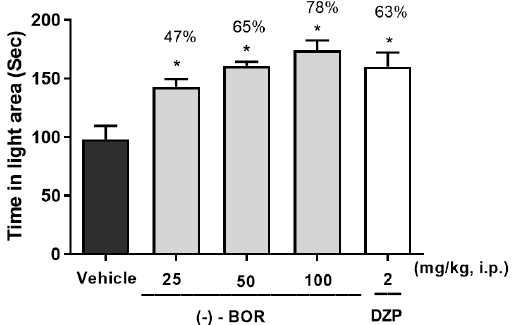
Figure 4. The effect of (–)-BOR (25, 50, and 100 mg/kg, i.p.) and DZP (2 mg/kg, i.p.) on the light-dark box test with mice ( n = 6). Each bar represents the mean ± S.E.M of the time in seconds (sec) of the animals in the clear compartment. * p < 0.05 is significant compared to the vehicle group (ANOVA and the Student-Newman-Keuls test as the post hoc test).